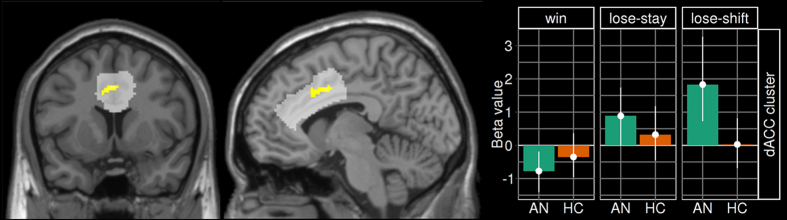
Group-Feedback interaction.Left: Brain map depicting the interaction effect with peak at x = −11, y = 6, z = 36 [F(2,140) = 9.5, pFWE-SVC <0.001]. ACC ROI is highlighted in light grey. Right: Extracted beta values of the dACC cluster region across groups and feedback-condition depicted as a bar chart (means with 95% CI).